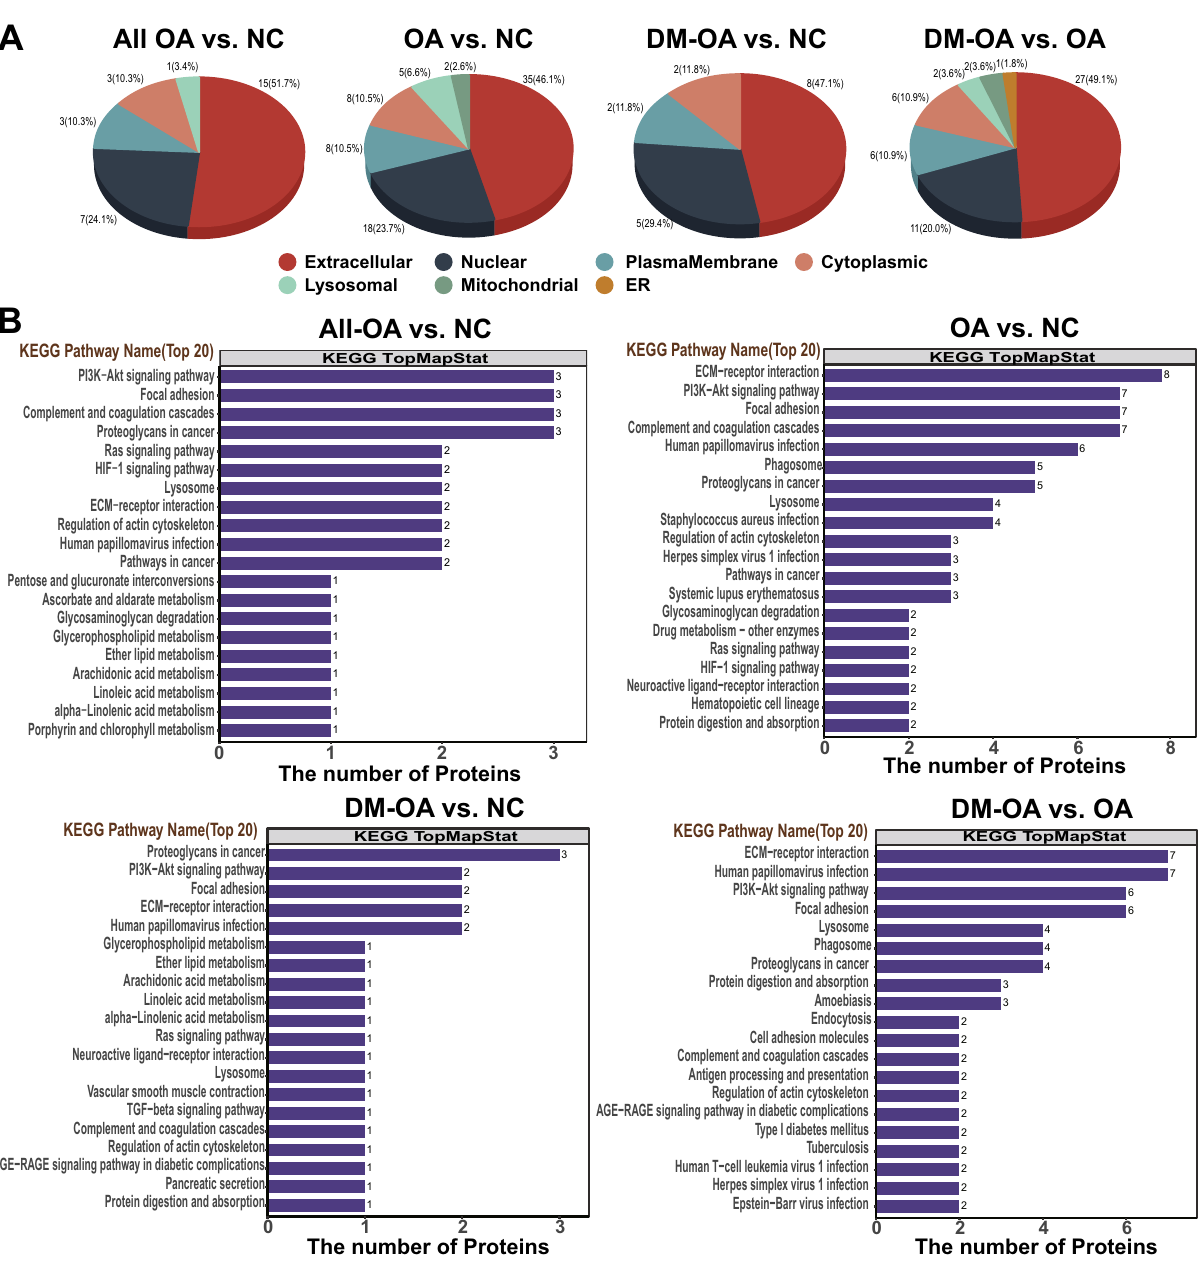
Figure 3. Functional annotations predicted by KEGG pathway analysis of N-glycopeptides. ( A ) Predictive subcellular organelle localization of N-glycopeptides with differential abundances identified in this study